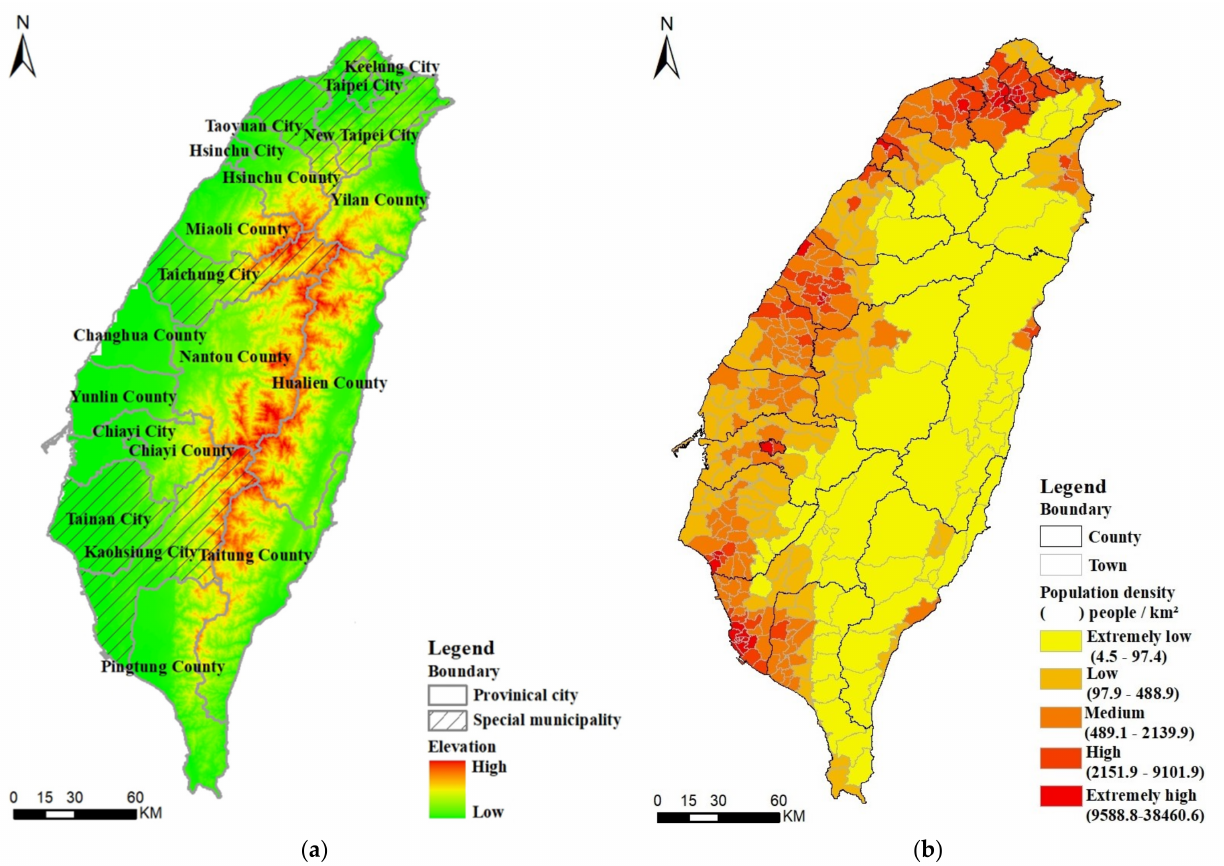
Figure 1. Study Area: ( a ) Scope of empirical research; ( b ) Density of the registered population in 2020. In 2020, Taiwan’s per capita gross domestic product reached US$28,400. The majority of Taiwan’s population and its industrial development are concentrated in the western coastal plain. The Taiwan High-Speed Rail, which began operations in 2007, extends along the western coastal plain. Taiwan’s six special municipalities are also all located in the western coastal plain, and in 2020, their population accounted for 68.8% of Taiwan’s registered population. Existing data sets have substantially varied in the scale of towns (Table 1). According to the 349 towns’ registered population in 2020, using the geometrical interval classification function of the ArcGis software (version 10.3) classifies the population density. Population density is divided into five grades: extremely low, low, medium, high, and extremely high (Figure 1b). The population density of the west coast of Taiwan